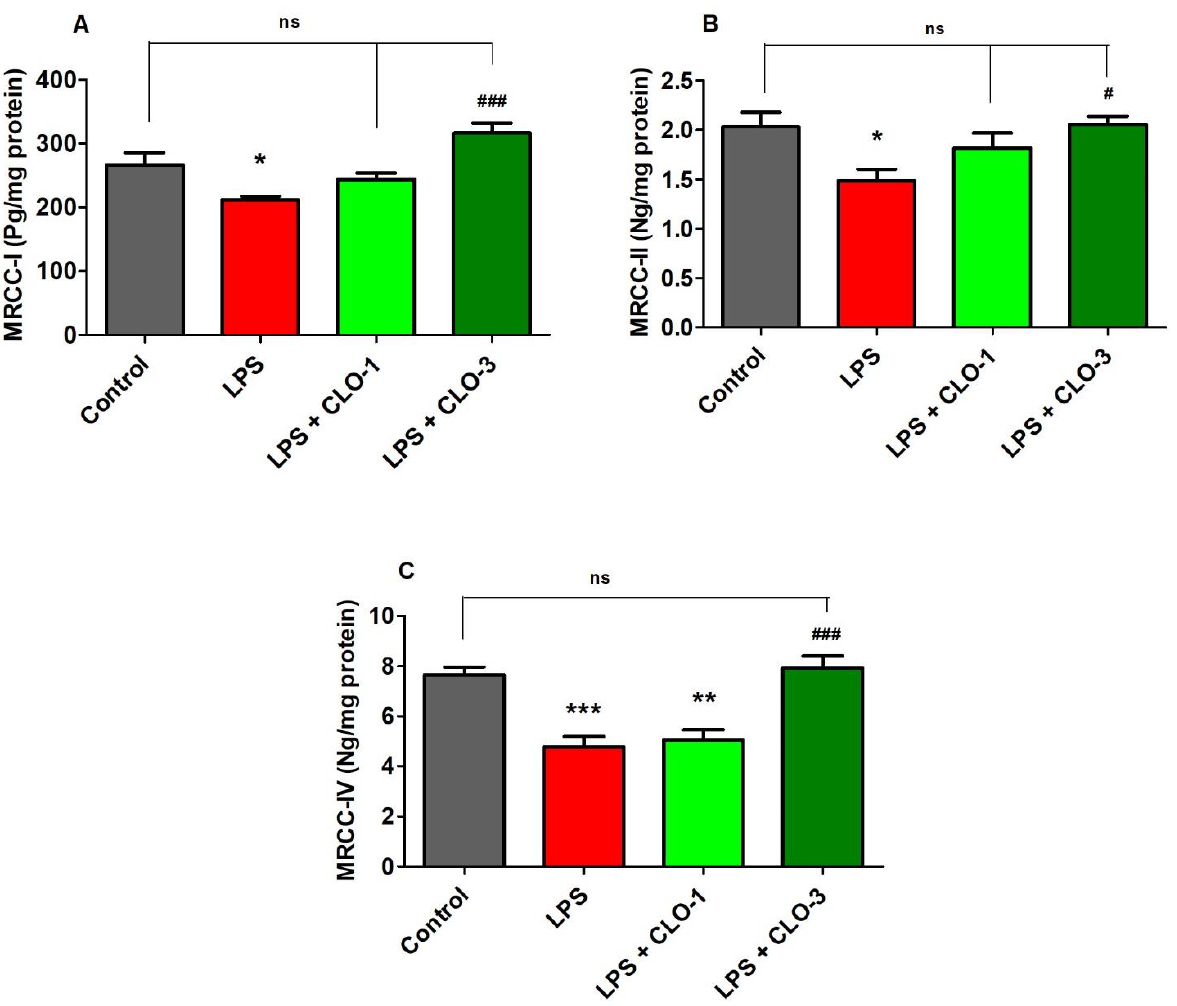
Figure 5. Effect of clobenpropit (CLO) on mitochondrial respiratory chain complex (MRCC) ( A ) MRCC-I, ( B ) MRCC-II, and ( C ) MRCC-IV activities in lipopolysaccharides (LPS)-treated mice brains. LPS-CLO-1 and LPS-CLO-3 refer to the administration of clobenpropit (1 or 3 mg/kg, p.o., respectively) and lipopolysaccharides (250 μg/kg, i.p.). MRCC levels were decreased with administration of LPS injection and the levels were increased with oral administration of CLO. The results are expressed as mean ± SEM ( n = 6). One-way ANOVA ( F (3,20) = 10.76, p < 0.001 for MRCC-I; F (3,20) = 4.270, p < 0.05 for MRCC-II; F (3,20) = 16.85, p < 0.001 for MRCC-IV) was followed by Tukey – Kramer multiple comparisons tests. * p < 0.05, ** p < 0.01 and *** p < 0.001 as compared to the control group; ns, not significant as compared to the control group; # p < 0.05 and ### p <0.001 as compared to the LPS-treated